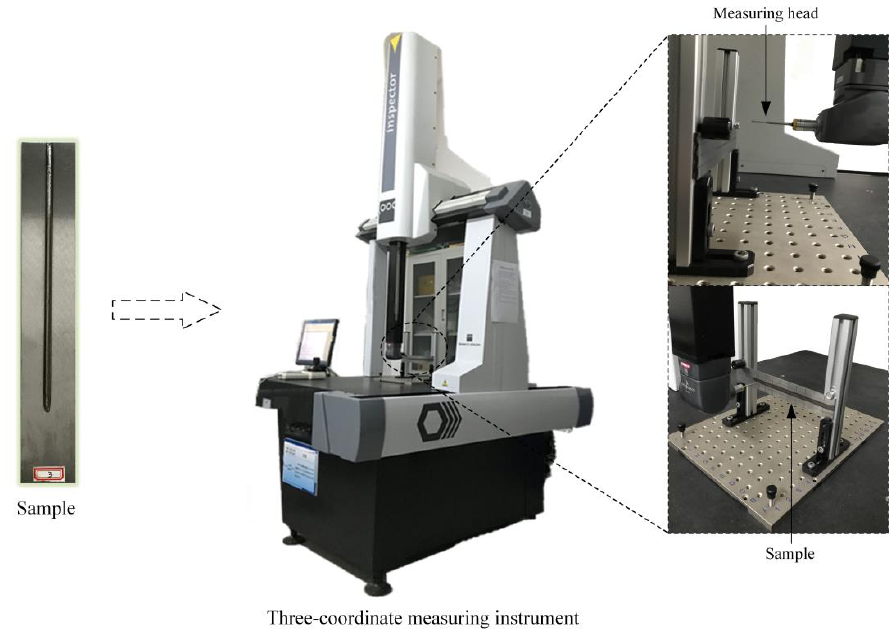
Figure 4. Deformation measurement process.